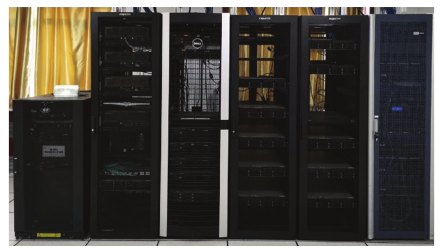
Figure 4: Microseismic monitoring center.